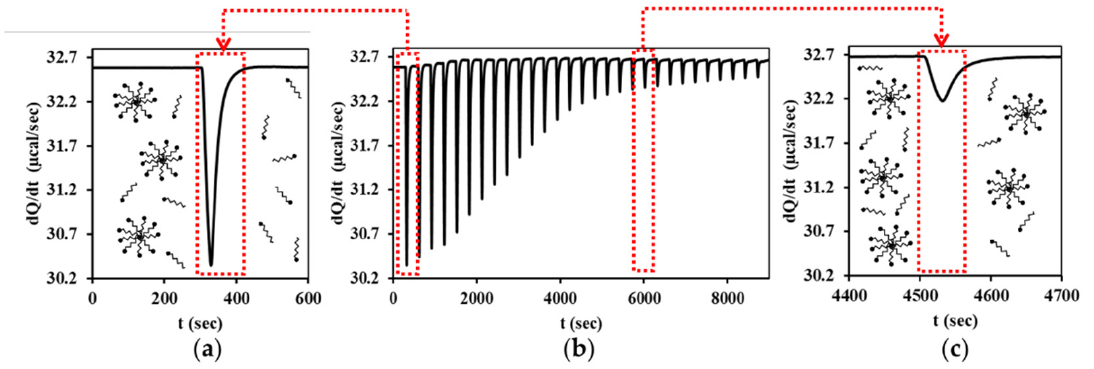
Figure 1. ITC raw data for the titration of nonionic surfactant (TX) at 25 °C in the middle ( b ) of the graph and a schematic representation of the calorimetric signals and processes characteristic of the pre- ( a ) and post-micellar ( c ) phases.